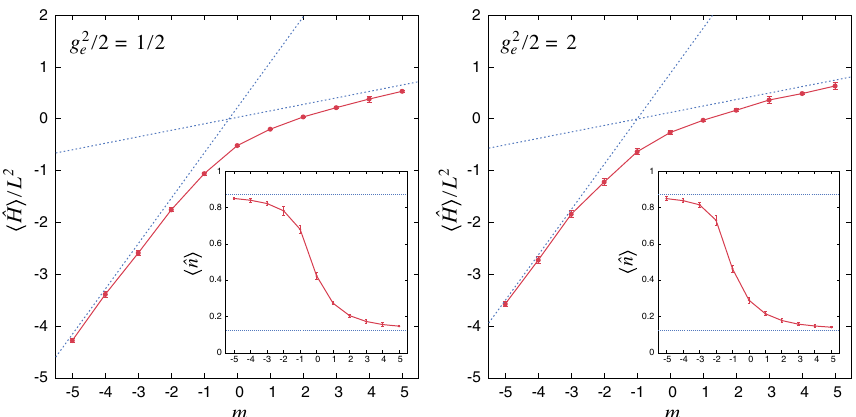
FIG. 10. Ground-state energy density and particle density (insets) as a function of the bare mass m for an 8 × 8 lattice with ρ ¼ − 1 = 8 , i.e., in the Q ¼ − 8 charge sector. In the left panel, the transition between the two regimes occurs at m ∼ − 1 = 4 , while in the right panel, it is located at m ∼ − 1 . Dashed lines are the asymptotic values in the zero-order perturbative